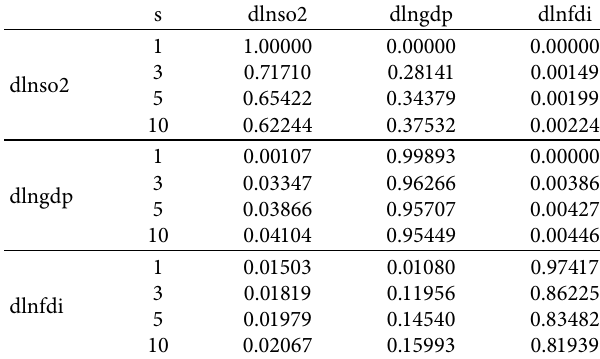
Table 5: The PVAR variance decomposition results of Model (1).